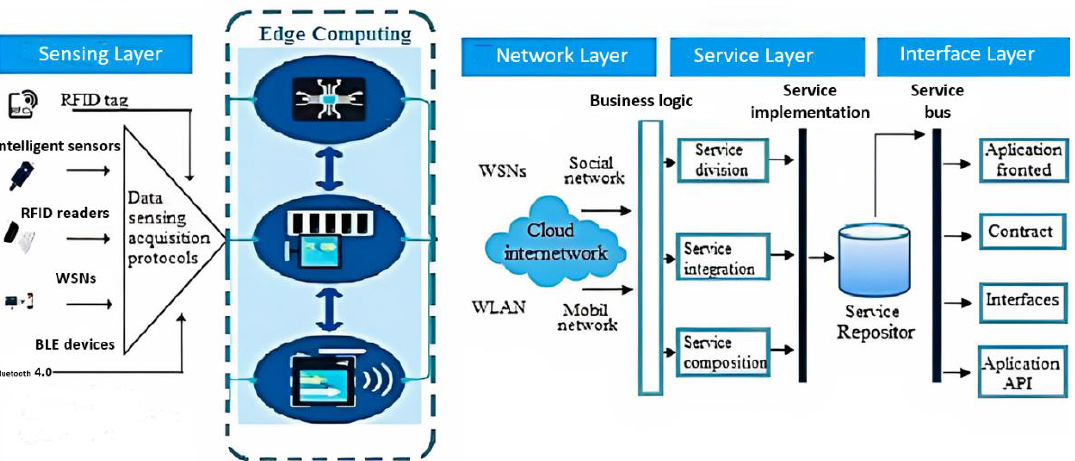
Figure 1. Intelligent Data Processing Layer [12]. Sensing Layer: To detect and gather information, this layer consists of sensing tools including smart sensors, RFID, and IoT client components. Edge (Pre-processing) Layer: The pre-processing (edge) layer, where the data detected by the sensors in the detection layer is filtered and cleaned from anomalies before exiting to the network layer. Network Layer: This is the layer that supports the Internet and other device connectivity infrastructure. Service Layer: The process of maintaining and offering services to users or other apps is visible at this layer. Interface Layer: This layer offers users or other services an interface